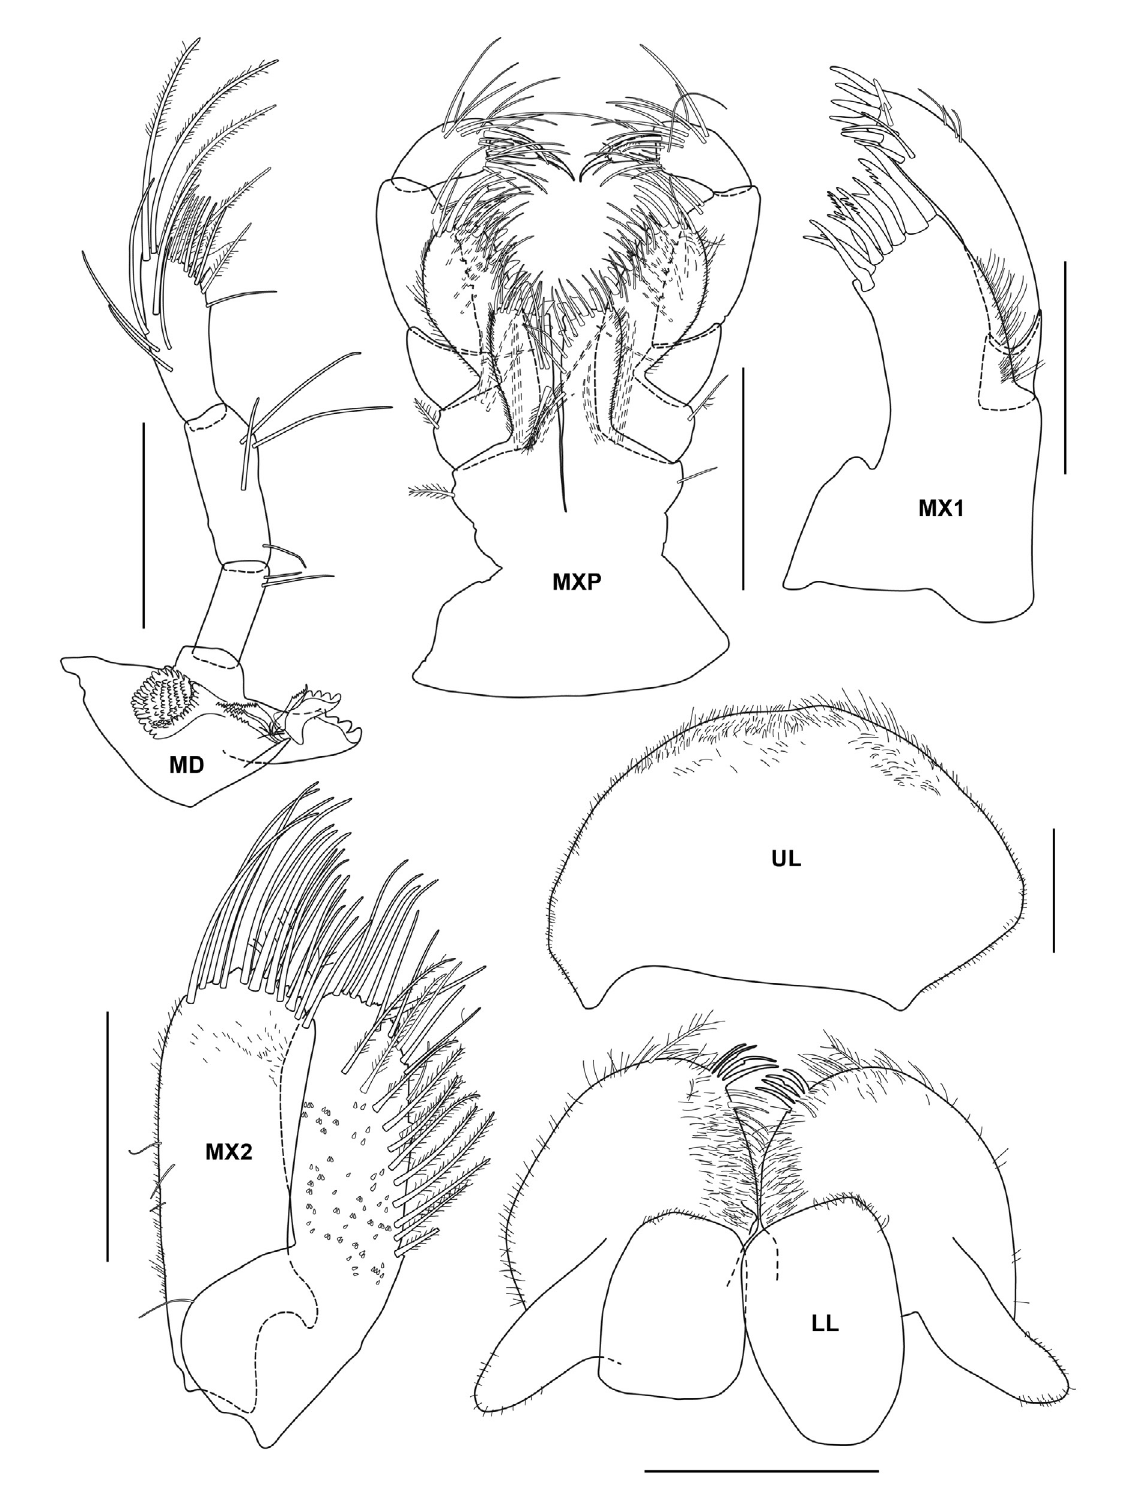
Fig. 4. Grandidierella pawaiensis sp. nov., holotype, ♂ (ZRC 2018.0493). Scale bars: UL = 0.05 mm; MD, MXP = 0.2 mm; remaining scales = 0.1